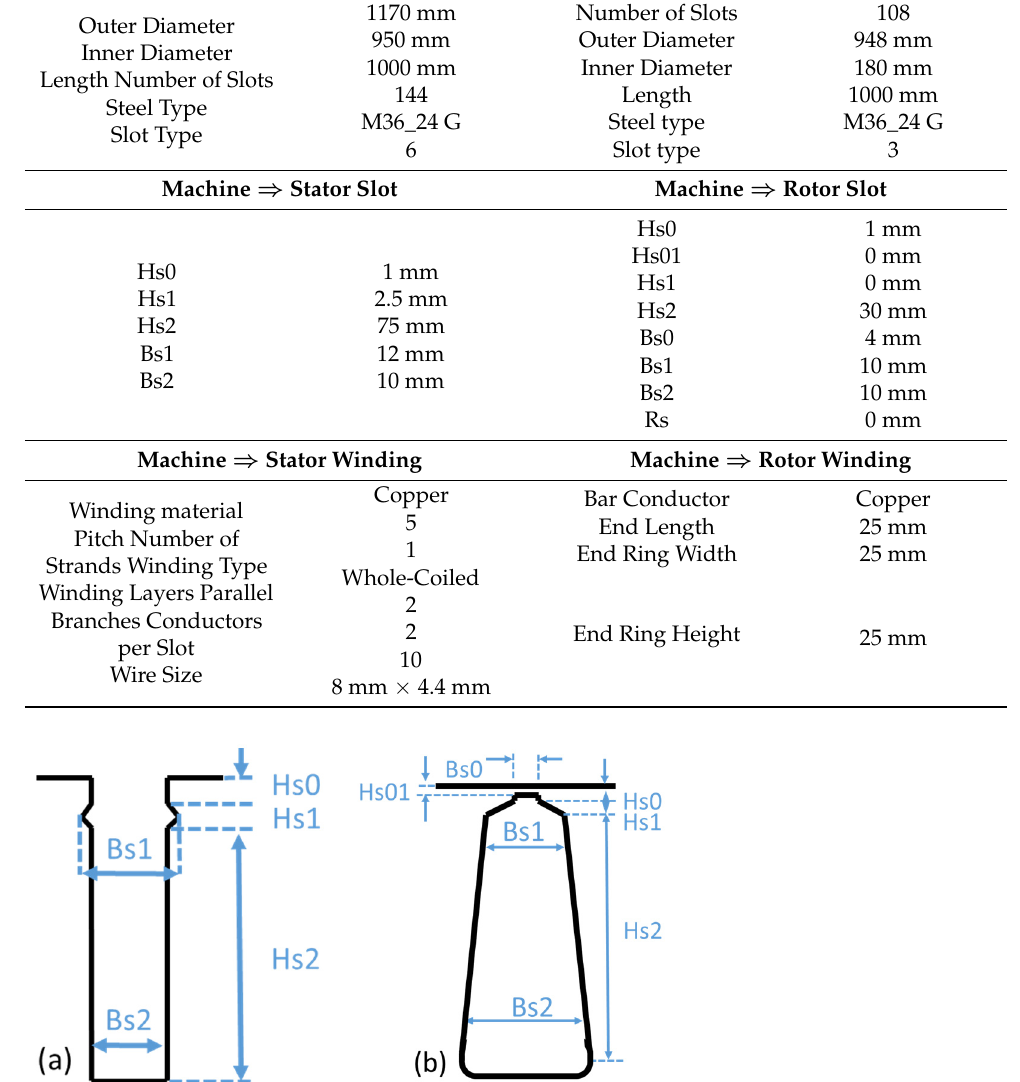
Figure 7. Parameters of a stator slot and a rotor slot. ( a ) Stator Slot dimensions. ( b ) Rotor Slot di- mensions.